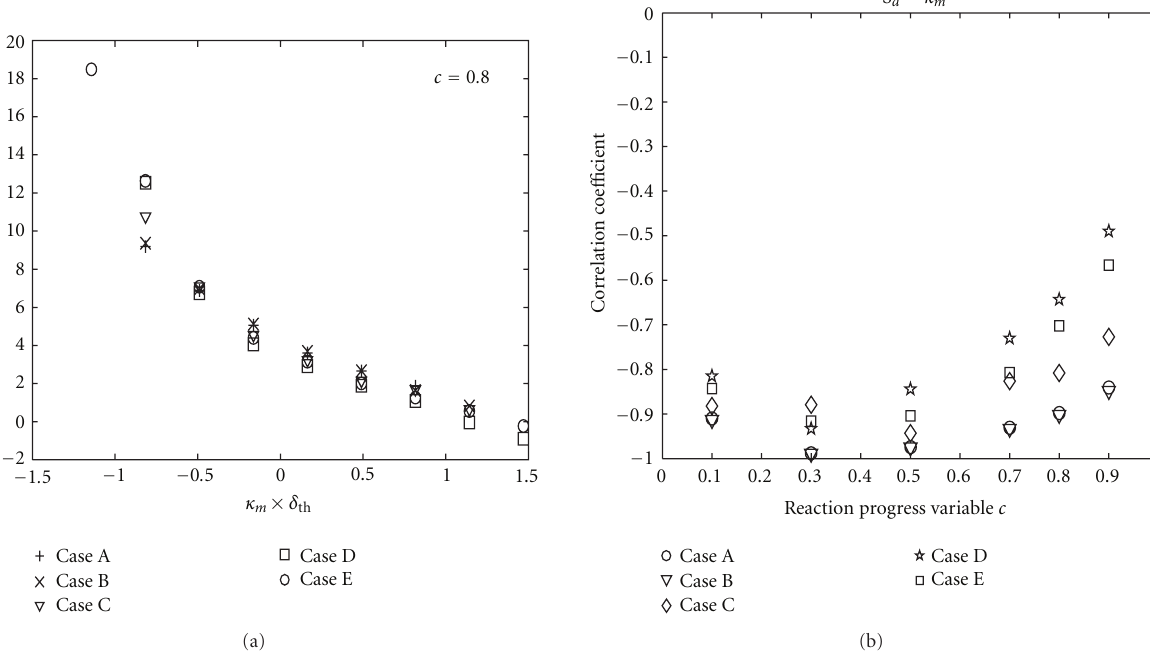
Figure 8: (a) Variation of mean values of S d /S L conditional on normalised curvature κ m × δ th for the isosurface at c = 0.8. (b) Variation of the correlation coe ffi cients between S d and κ m on the isosurfaces at c = 0.1 to 0.9 for all